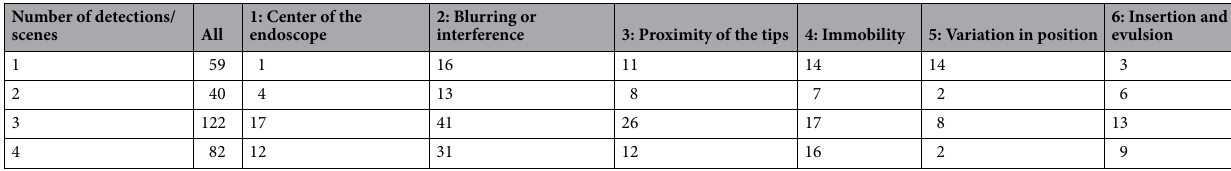
Table 4. Breakdown of errors by